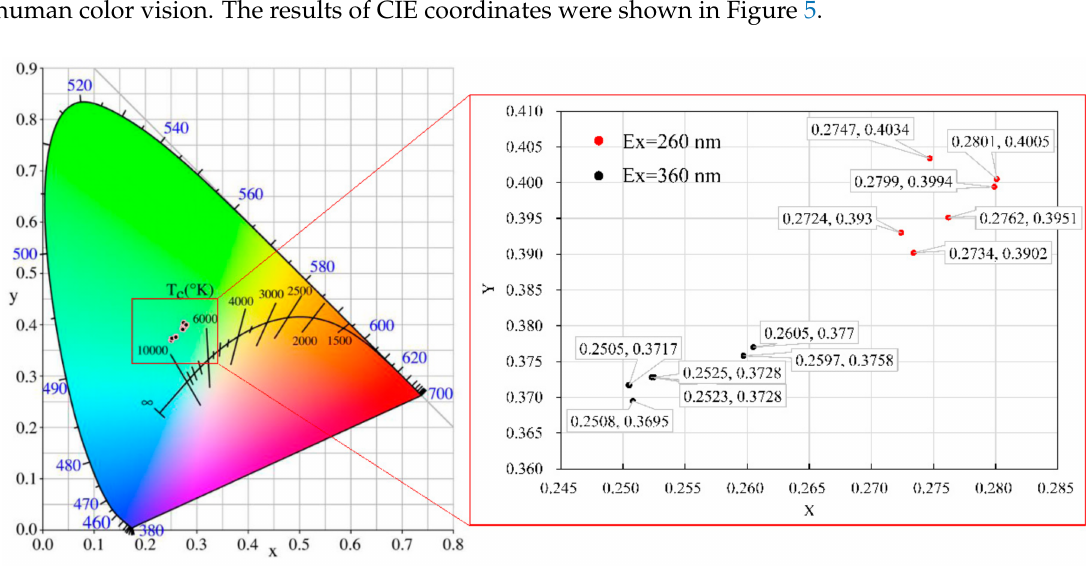
Figure 5. CIE coordinates of bitumen at 260 nm and 360 nm of excitation